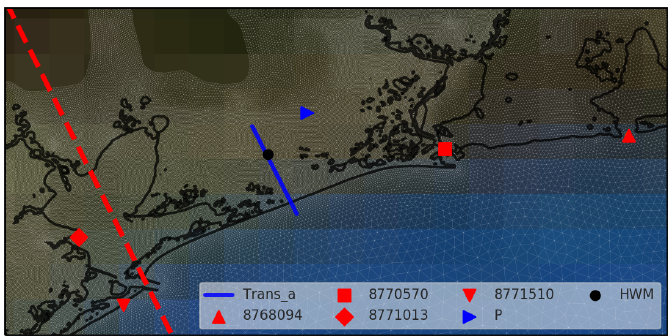
Figure 6. Red markers are the locations of the tidal gauges. The legend shows the stations ID numbers. Red dashed line is Hurricane Ike’s best track. The blue line and blue triangle are transect and time series plot shown in Figure 5 and time series of the test point is presented in Figure 7, respectively. Black circle shows the location of USGS High Water Mark observation shown in Figure 5. All model configurations and results are pre-decisional and for official use